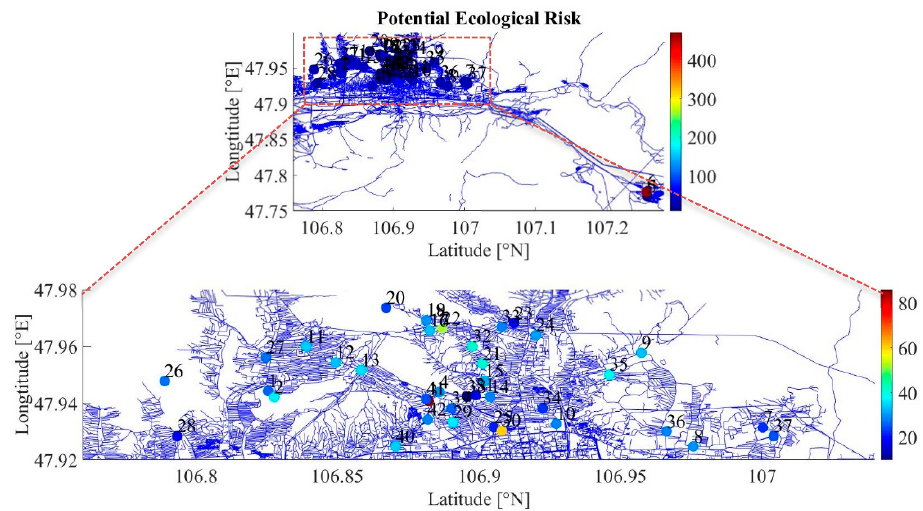
Figure 10. Potential ecological risk to the environment.